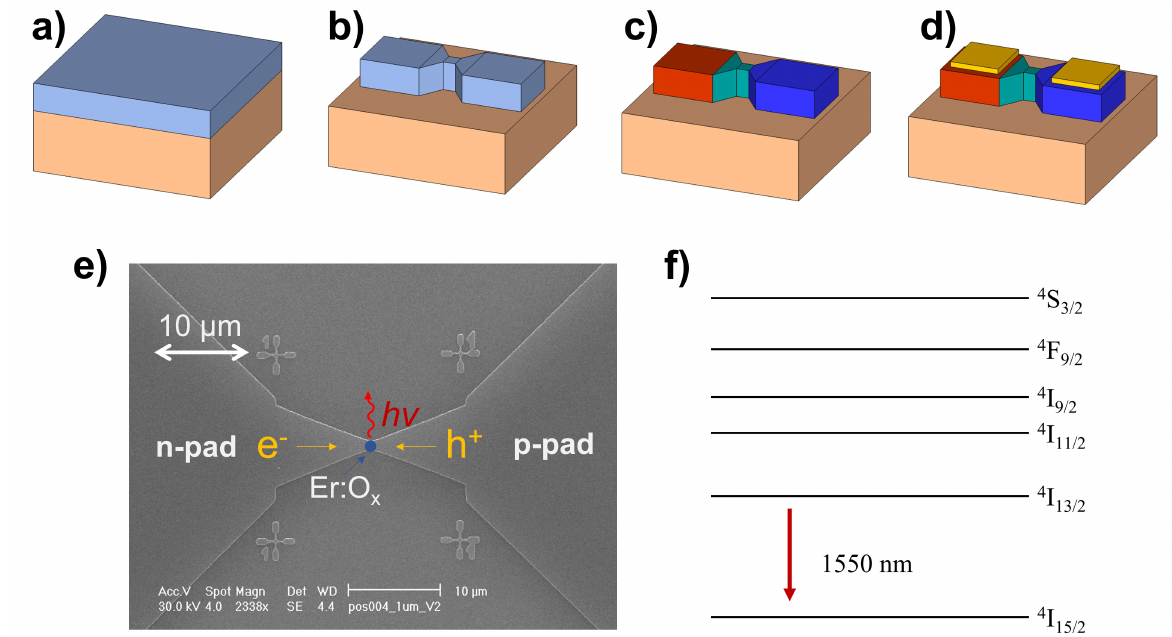
Figure 1. ( a ) Silicon on insulator wafer, the silicon layer is 220 nm-thick and it lies on a 3 µm-thick SiO 2 buried layer. ( b ) Mesa of the device defined by electron beam lithography (30 keV) using a positive resist (PMMA). The etching is performed via a Bosch process. ( c ) Sketch illustrating the doping of the device. In red, the p-area doped with boron, in blue, the one doped with phosphorous, and, in green, the region co-doped with erbium and oxygen. ( d ) Final device. In yellow, the electrical contacts made of titanium and gold. ( e ) Scanning electron microscopy image of the device. Our simulations indicate that most of the photons are confined in the silicon layer and just 6% of them are emitted in open space in the vertical direction. ( f ) Energy level structure in Er 3 + , the transition exploited in our device is